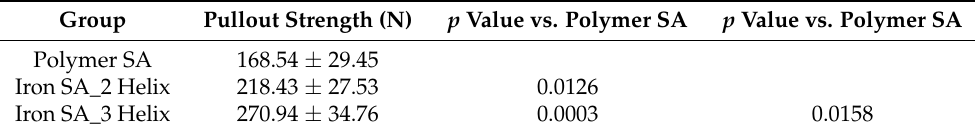
Table 1. In vitro ultimate pullout strength of suture anchors.